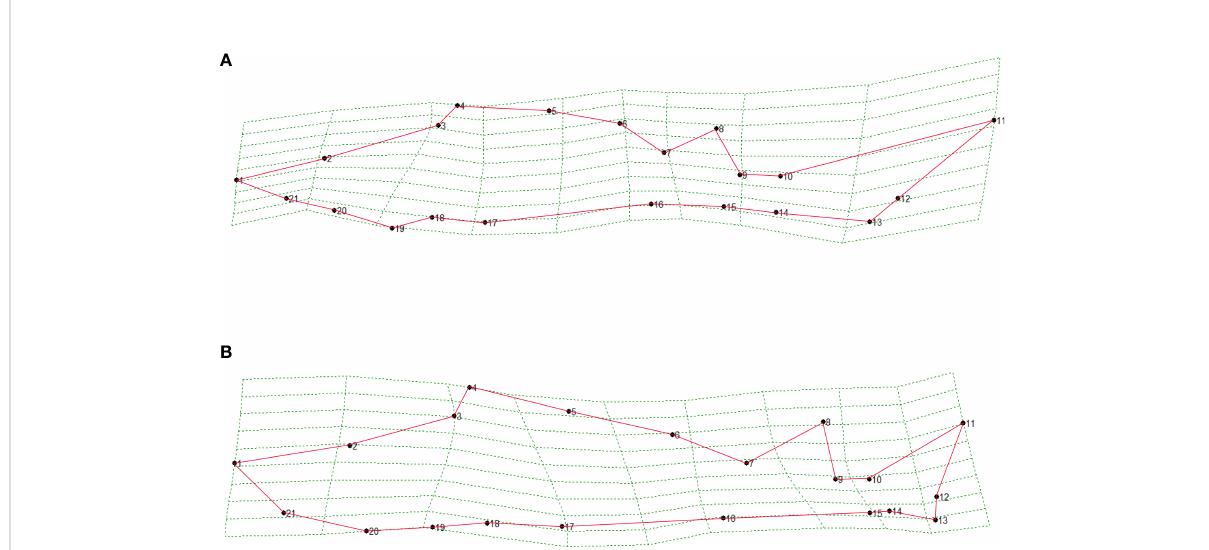
FIGURE 8 Grid deformation and variation visualization of morphological features of bold (A) and shy (B) test Siberian